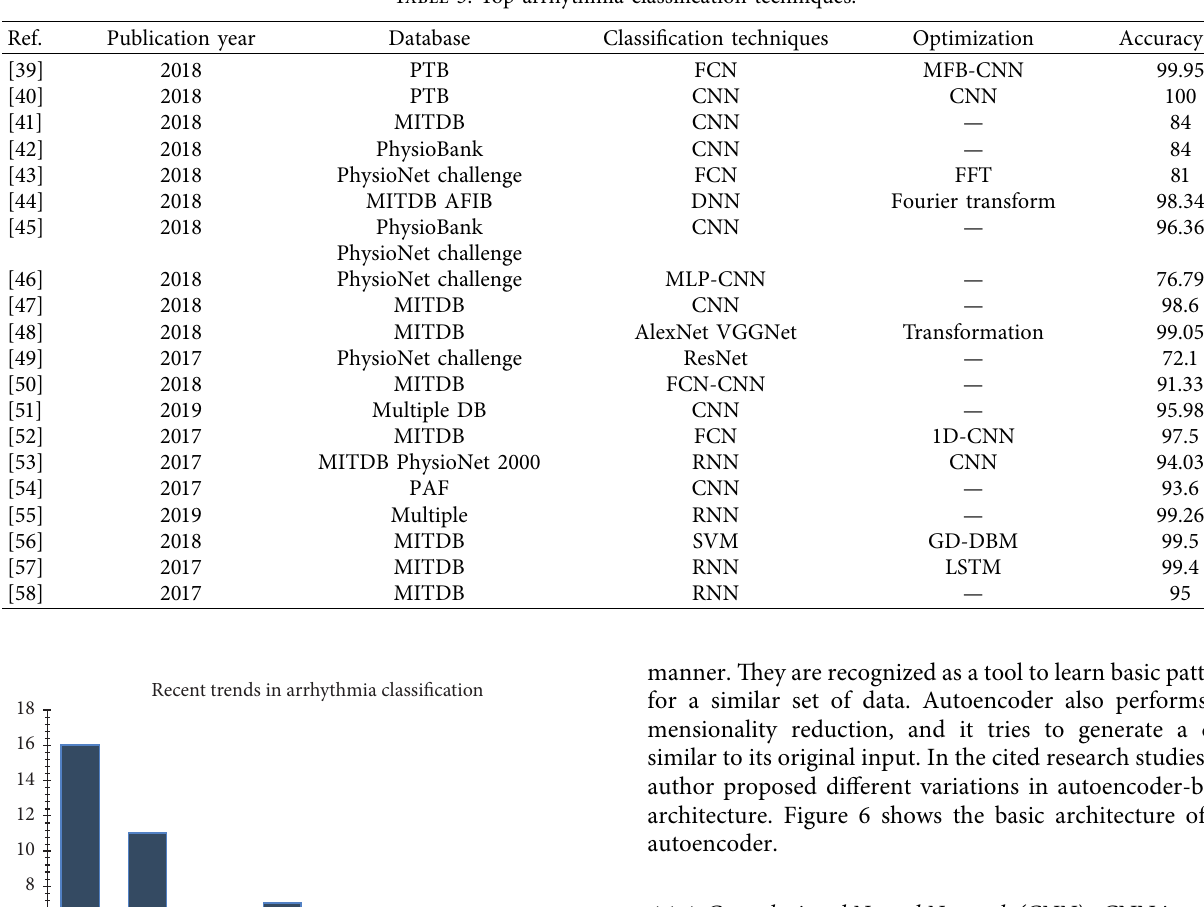
Table 3: Top arrhythmia classification